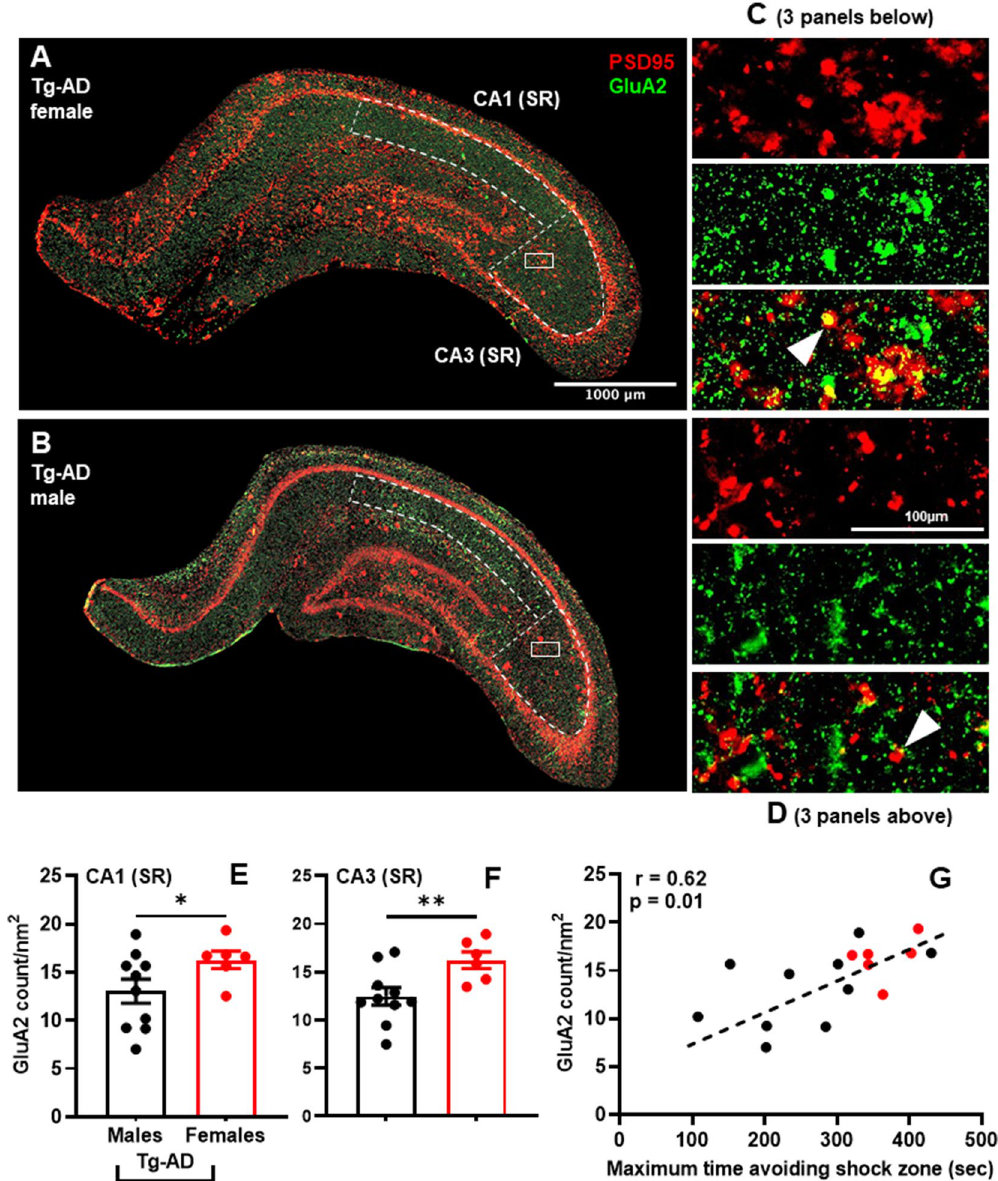
Figure 5. Tg-AD females exhibit increased levels of GluA2 in the hippocampus compared to Tg-AD males. IHC analysis for the AMPA receptor GluA2 subunit (green) and the scaffolding protein PSD95 (red) of the right dorsal hippocampus of Tg-AD females ( A ) and Tg-AD males ( B ), 10× magnification, 1000 µm scale bar. Smaller panels on the right ( C and D ) represent the magnification of the respective small white boxes depicted in ( A ) and ( B ), 100 µm scale bar, showing the two stains (GluA2, green and PSD95, red) separately and co-localized (yellow, white arrows). Hippocampal CA1 SR and CA3 SR subregions are highlighted with white dashed lines. Tg-AD female rats had significantly higher GluA2 levels in the ( E ) CA1 (SR) and ( F ) CA3 (SR) hippocampal subregions compared to Tg-AD males. Unpaired one-tail t-tests with Welch’s corrections were used for the comparison. *P < 0.05, **P < 0.01. ( G ) GluA2 levels (y-axis) directly correlates with cognitive behavior (x-axis). The correlation was evaluated by linear regression calculating the Pearson correlation coefficient. Tg-AD males (n = 9), Tg-AD females (n = 6). CA Cornu Ammonis, SR stratum